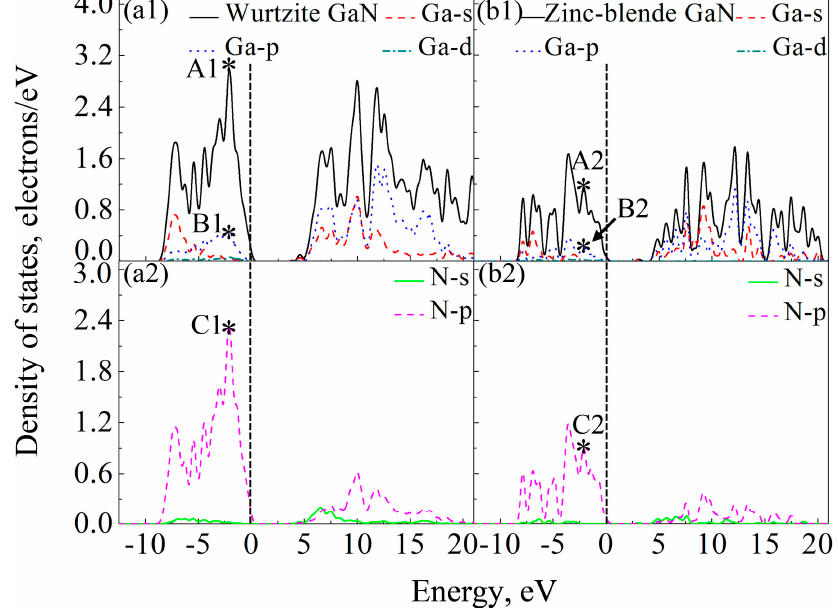
Figure 7. DOSs for the two GaN crystals and their atoms: ( a1 ) wurtzite GaN and Ga atoms; ( a2 ) N atoms in wurtzite GaN; ( b1 ) zinc-blende GaN and Ga atoms; and ( b2 ) N atoms in zinc-blende GaN. The mark * indicates the peak of DOS at − 2.1 eV